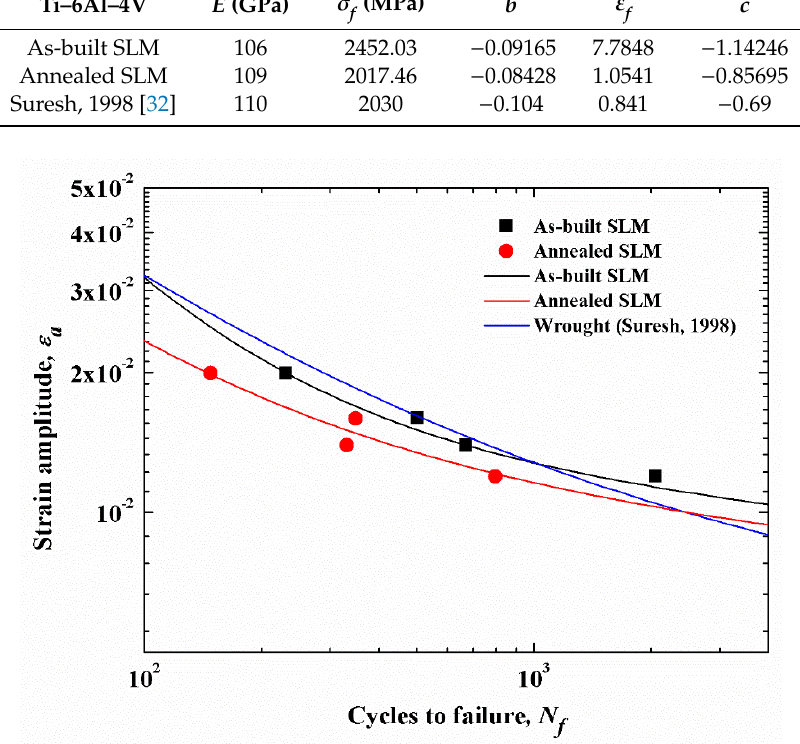
Figure 13. The total strain–life curves for selective laser melting (SLM) Ti–6Al–4V tested here compared to the data of wrought Ti–6Al–4V (data refer from Reference [32]).